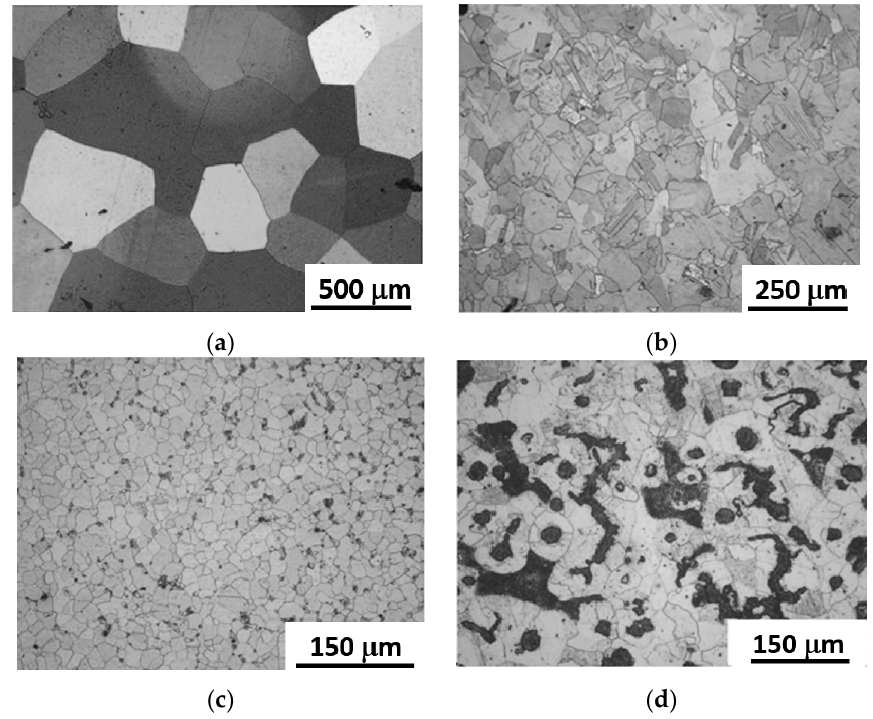
Figure 3. Optical micrography of commercially pure aluminum ( a ), DHP copper ( b ), 100 Cr6 steel ( c ), and cast iron ( d ).